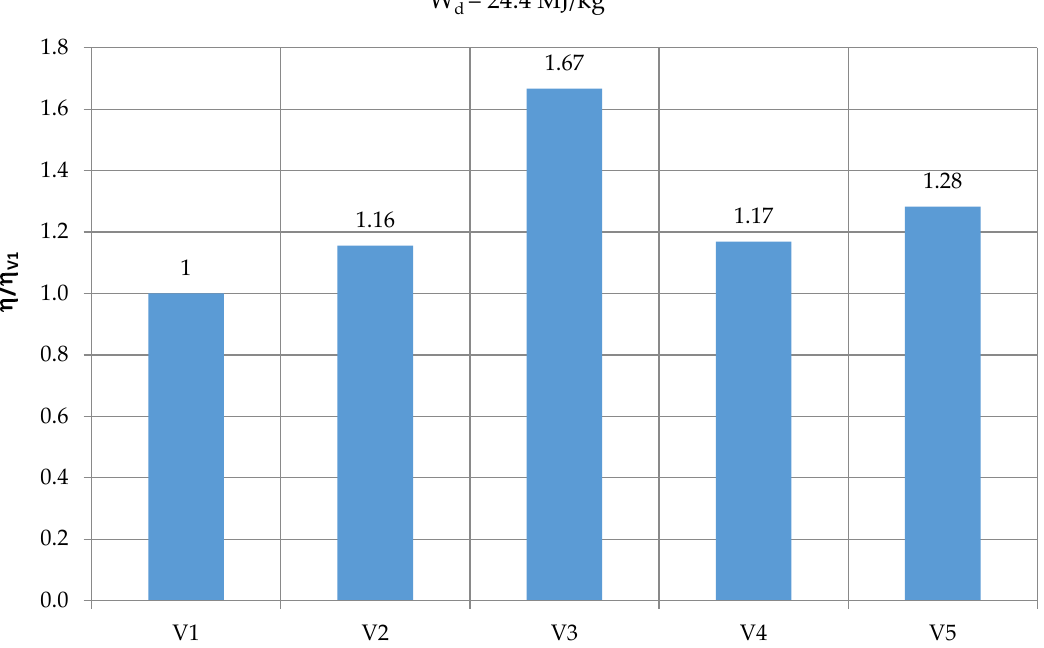
Figure 7. The e ff ect of the cycle structure on its e ffi ciency as compared to variant 1 for heating value Figure 7. The effect of the cycle structure on its efficiency as compared to variant 1 for heating value W d = 24.4 MJ / W d = 24.4 MJ/kg.